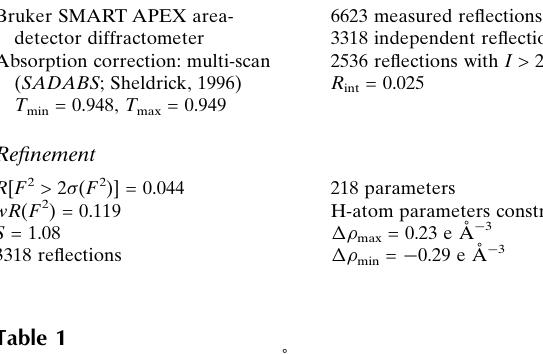
Selected geometric parameters (A˚ , (cid:3)